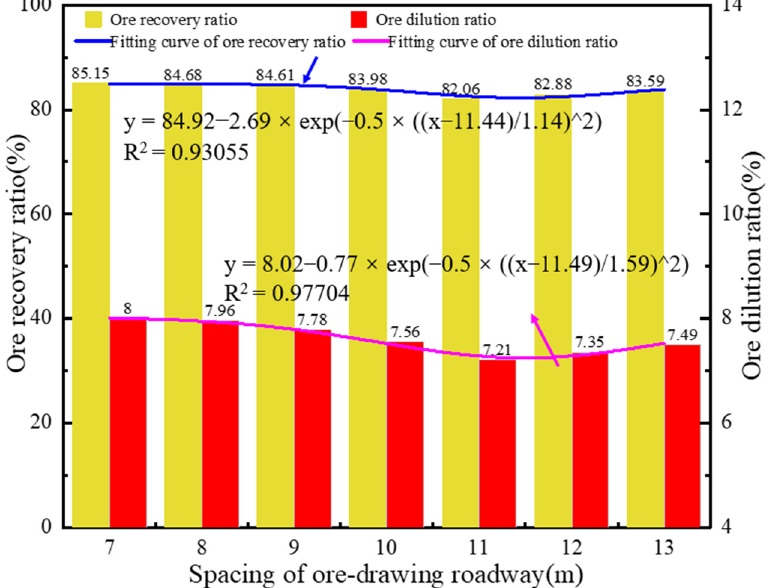
Figure 12. Effects of different mining roadway spacings on recovery ratio and dilution ratio.